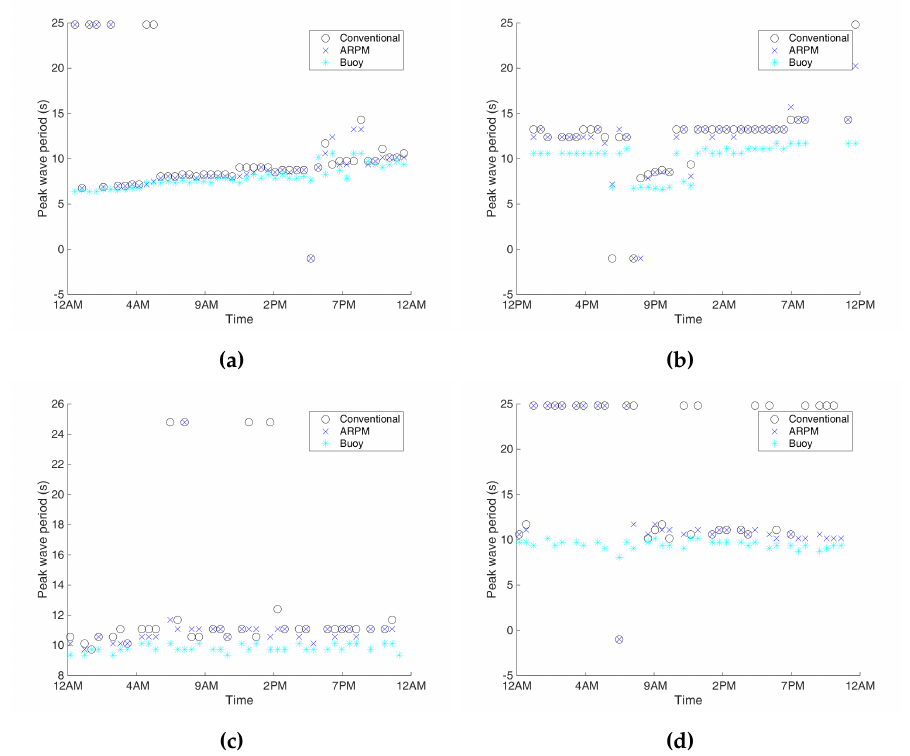
Figure 13. A comparison between the ARPM and the standard method in terms of the peak wave period. ( a – d ) 27 November, 29 November, 1 December and 3 December respectively.